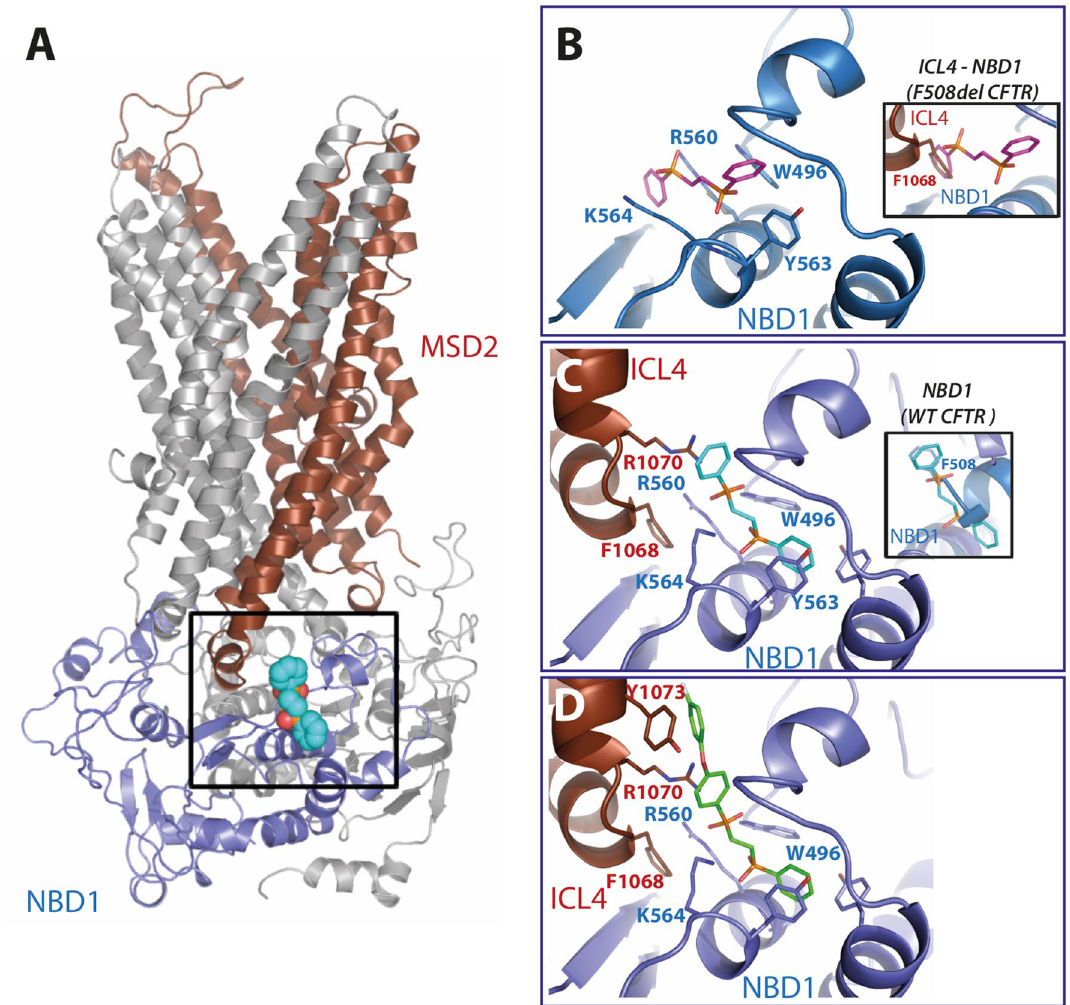
Figure 2. c407 interaction with the 3D structure of the F508del-CFTR MSDs:NBDs assembly. ( A ) Ribbon representation of the 3D structure model of the F508del-CFTR MSDs:NBDs assembly. NBD1 is colored in blue, MSD2 in brown red. The box highlights the position on this assembly of the putative c407 binding site, which is detailed in the right part of the figure. ( B ) Predicted c407 binding site in the context of the isolated F508del- NBD1 (extracted from the whole MSDs:NBDs architecture). In the inset is represented superimposition with the 3D structure of F508del MSDs:NBDs assembly, in order to highlight the similar position of the c407 (pink) external phenyl ring and ICL4 F1068 (red brown). ( C ) Predicted c407 binding site in the context of the F508del MSD:NBD assembly (same orientation as in Panel B). In the inset is represented the superimposition with the 3D structure of WT NBD1, in order to highlight the similar position of the c407 (green) external phenyl ring and F508 (blue). ( D ) Extended c407 analog, G1, is shown with the extension designed to interact with Y1073, thereby adding contacts with